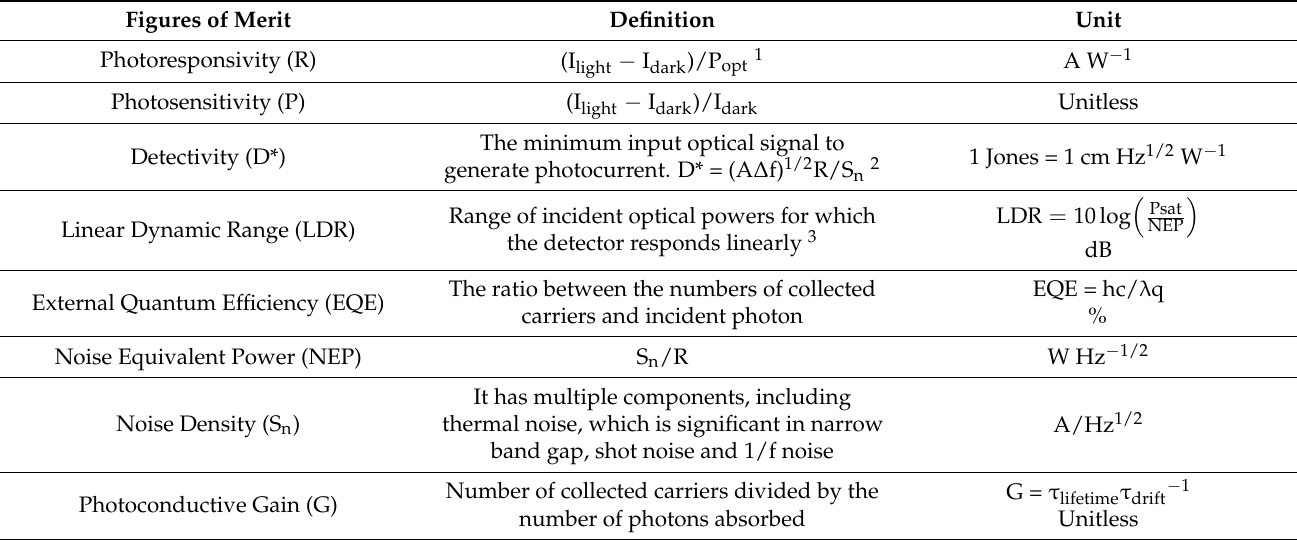
Table 2. Phototransistor merits of performance